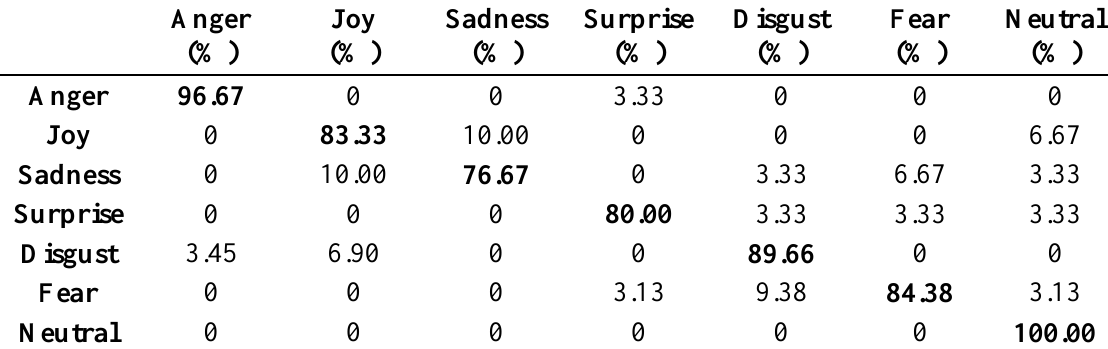
Table 4. Confusion matrix of classification results when NNLS performs best with the raw